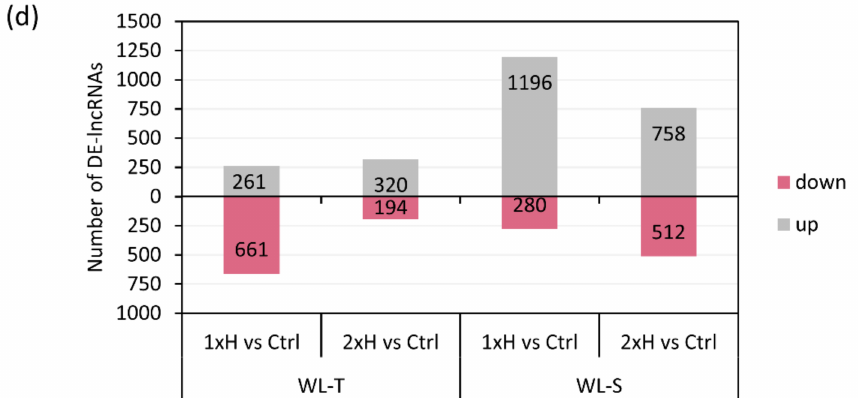
Figure 1. Characterization of lncRNAs in two cucumber accessions (WL-T and WL-S) under long-term waterlogging. ( a ) Classification of lncRNAs on the basis of their genomic locations with respect to adjacent protein coding genes. ( b ) Distribution of lncRNAs across chromosomes. ( c ) Transcript size distributions for all lncRNAs. ( d ) Number of DE-lncRNA (Differentially Expressed lncRNA) identified in each performed comparison with control conditions in both cucumber accessions. WL-T—waterlogging tolerant accession, WL-S—waterlogging sensitive accession, Ctrl—unstressed plants, 1xH—non-primed, once waterlogged plants, 2xH—primed, twice waterlogged